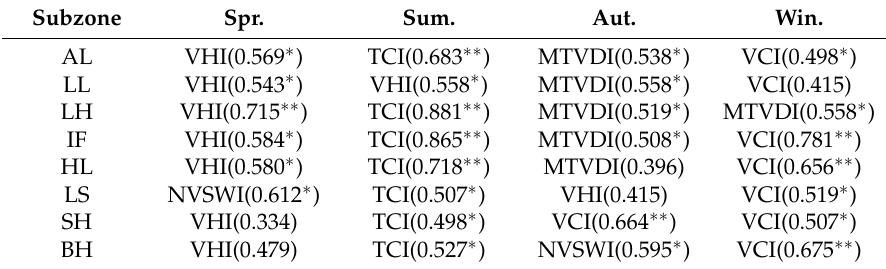
Table 4. The optimal remotely sensed drought indices (RSDIs) in various subzones. Spr., Sum., Aut., and Win. denote spring, summer, autumn, and winter, respectively. The values in parentheses are the correlation coefficients of drought grade results between the optimal index and the Standardized Precipitation Evapotranspiration Index (SPEI). “ ∗ ” means significance at the 95% confidence level and “ ∗∗ ” means significance at the 99% confidence level.